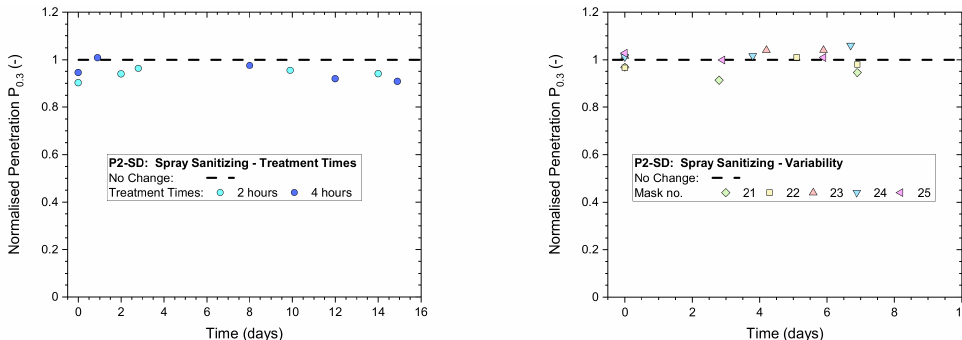
Figure 11. Normalized penetration P n0.3 from whole-mask screening testing of a P2-rated mask (Shanghai Da Sheng) exposed to continuous spray sanitizing actions ( left ) for 2 or 4 h; ( right ) variability between 5 masks from the same batch and box exposed to 4 h of continuous spray sanitizing